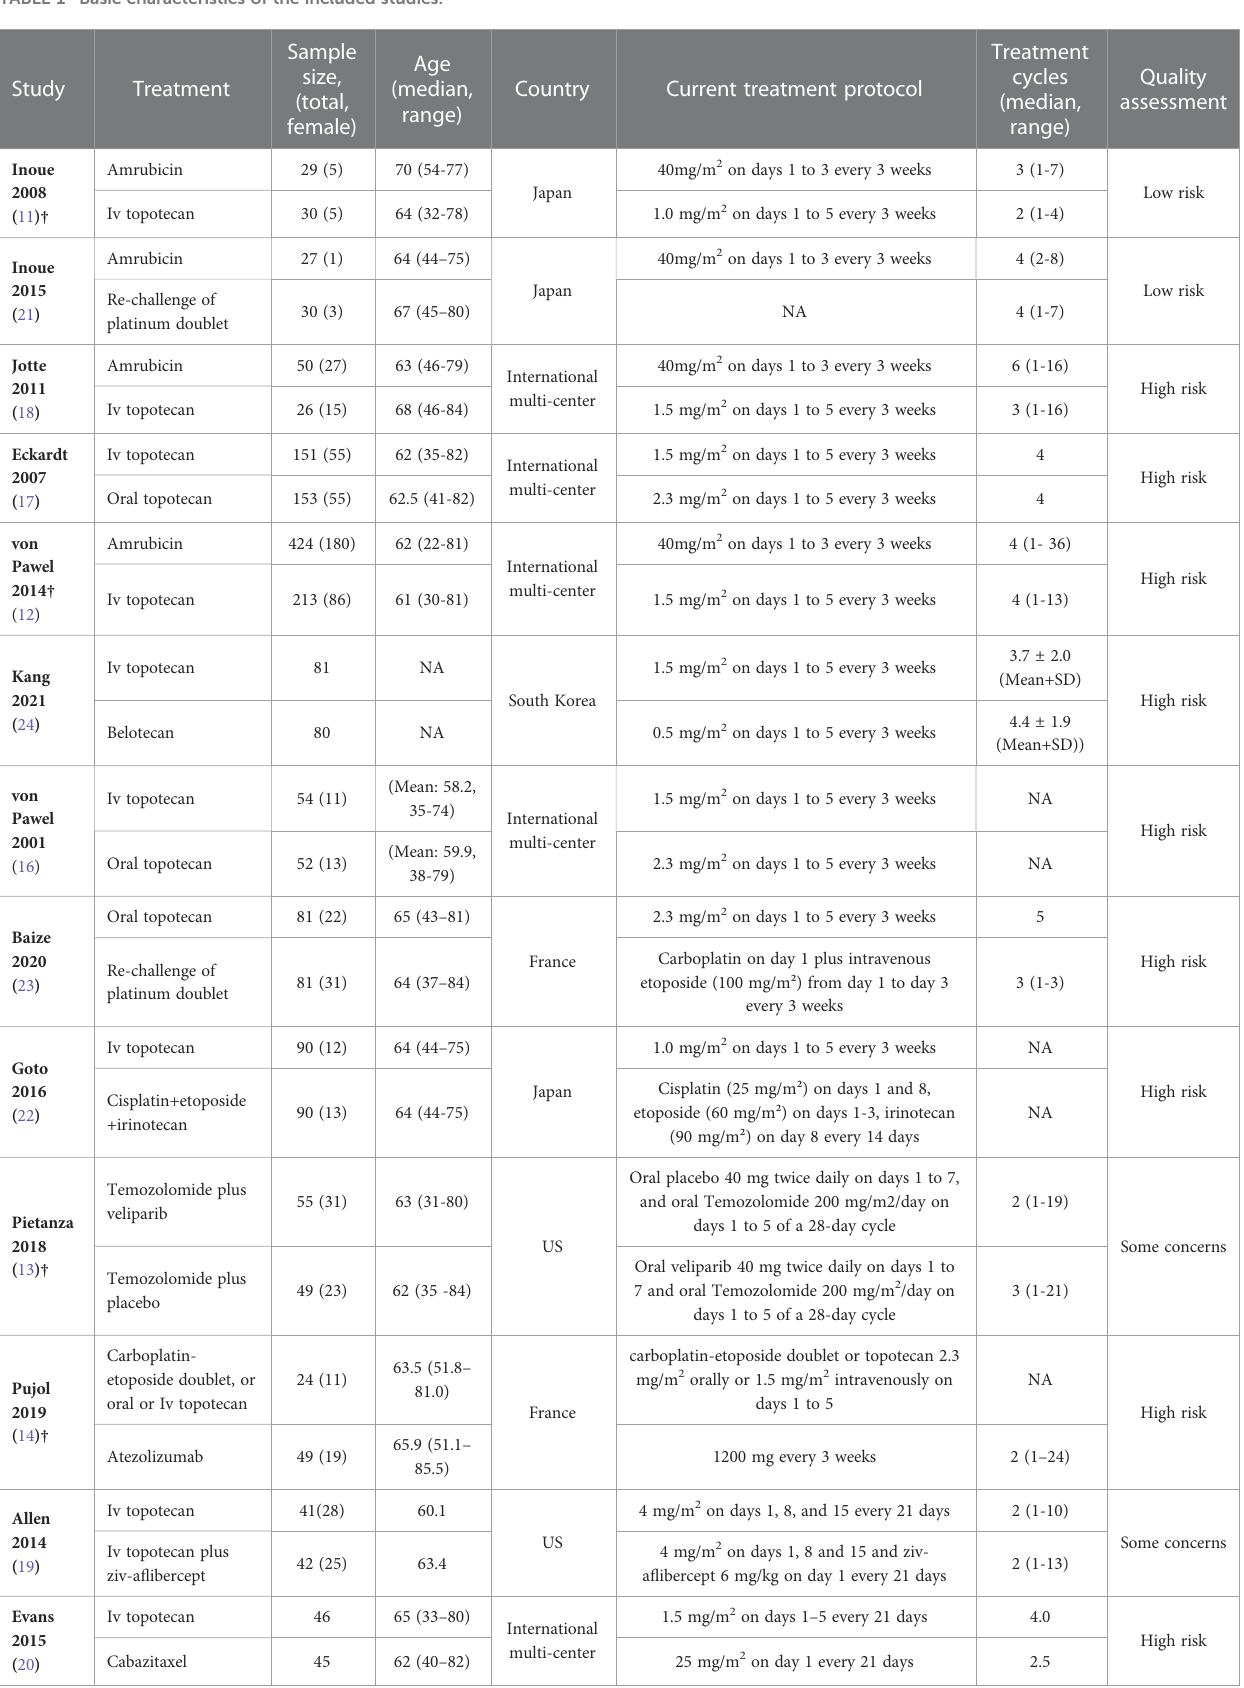
TABLE 1 Basic characteristics of the included